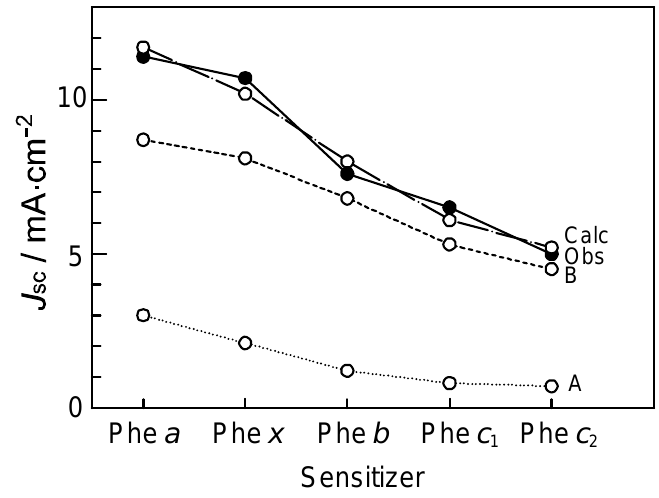
• + ) levels and the singlet- /D 0 0 (reprinted with permission 2